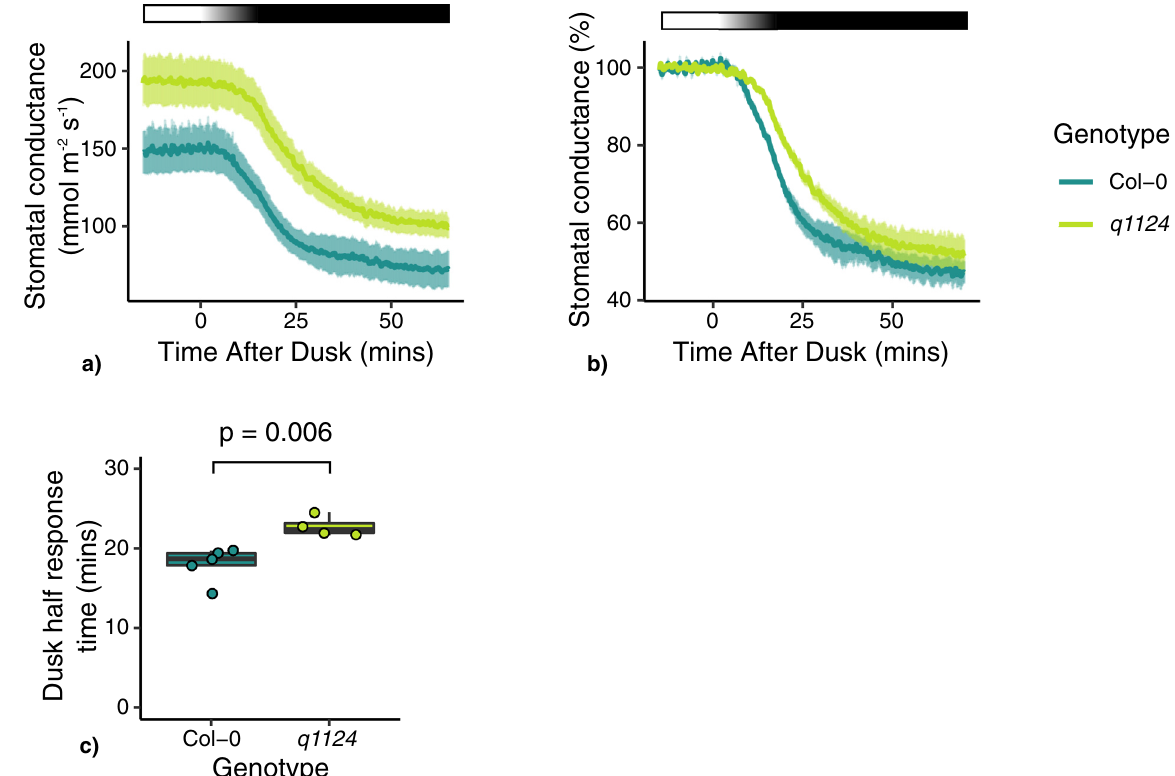
Figure 5. q1124 stomatal conductance response at dusk. Stomatal conductance of the q1124 quadruple ABA receptor over the dusk transition period. On the onset of dusk, the lights were dimmed over a 15 min period until completely turned off. ( a ) Absolute and ( b ) relative stomatal conductance values are presented as the mean ± s.e.m. ( c ) The time taken to reach half of the maximum stomatal conductance change (half response times) upon dusk are presented in boxplots showing the median and interquartile ranges. 4–5 plants measured per genotype. Light treatment is represented above each stomatal conductance plot, with black boxes representing darkness and white boxes representing light. A gradient represents the 15 min transition from light to